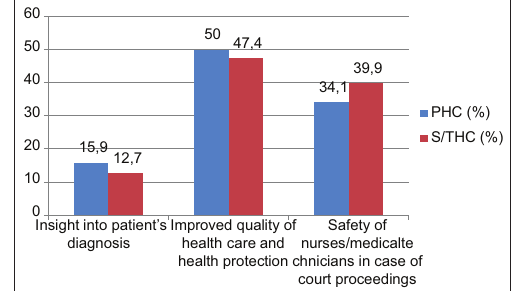
GRAPH 2. Advantages of submitted nursing documentation.